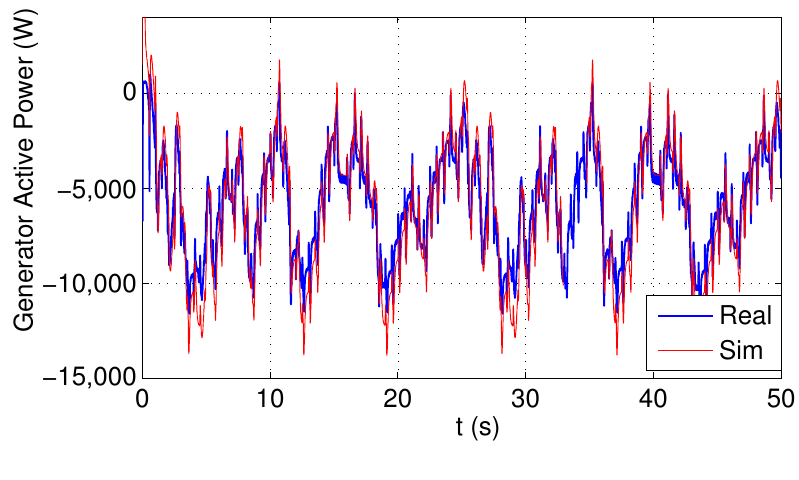
Figure 7. Real and simulated generator active power.